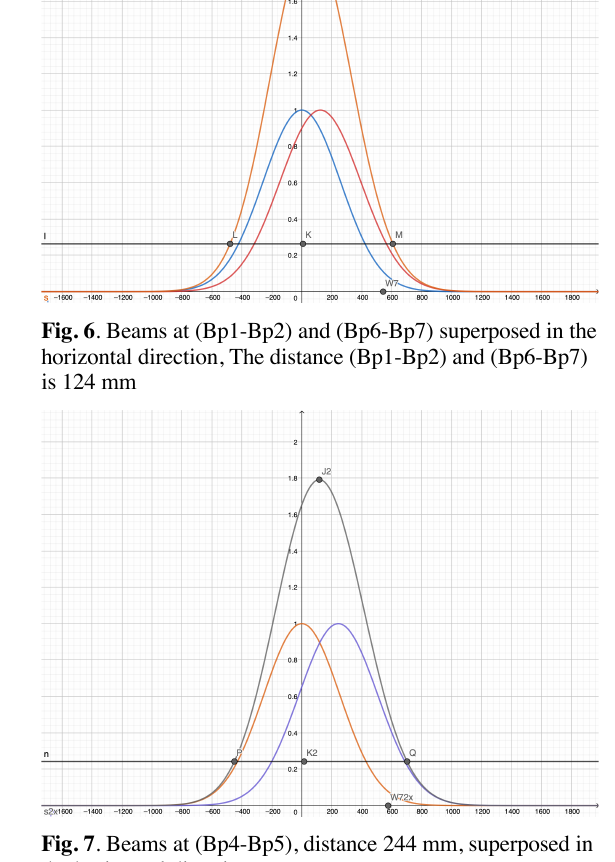
Fig. 7 . Beams at (Bp4-Bp5), distance 244 mm, superposed in the horizontal direction The six beams (Bp1+Bp2), (Bp6+Bp7) (see Fig. 6) and (Bp4+Bp5) (see Fig. 7), once merged horizontally and described as gaussian beams, are then further merged vertically. The beam sizes (radius at 1/e, projected on the plane tangential to the central column) are: (Bp1+Bp2) and (Bp6+Bp7) 543 mm horizontally